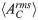
β-Power and the root mean square value of the activity as functions of the coefficient of variation vf, in the case of the network model.The β-Power and the 〈ACrms〉 were computed from the cortical LFP signal (Eq 9), when non-periodic stimulation patterns configured with H0DBS=7 and δ = 0.5 ms were applied to the STN nuclei. The β-Power has been normalized with respect to that obtained for the system in the oscillatory state without stimulation (H0DBS=0). The 〈ACrms〉 correspond to the root mean square value of the activity averaged over all the cortical neurons. The non-periodic stimulation patterns were generated using random instantaneous frequencies with a mean value of 〈fDBS〉 = 130 Hz. Each point in the graph correspond to the mean value and the standard deviation of 10 realizations for each vf value (see section “Materials and methods”).